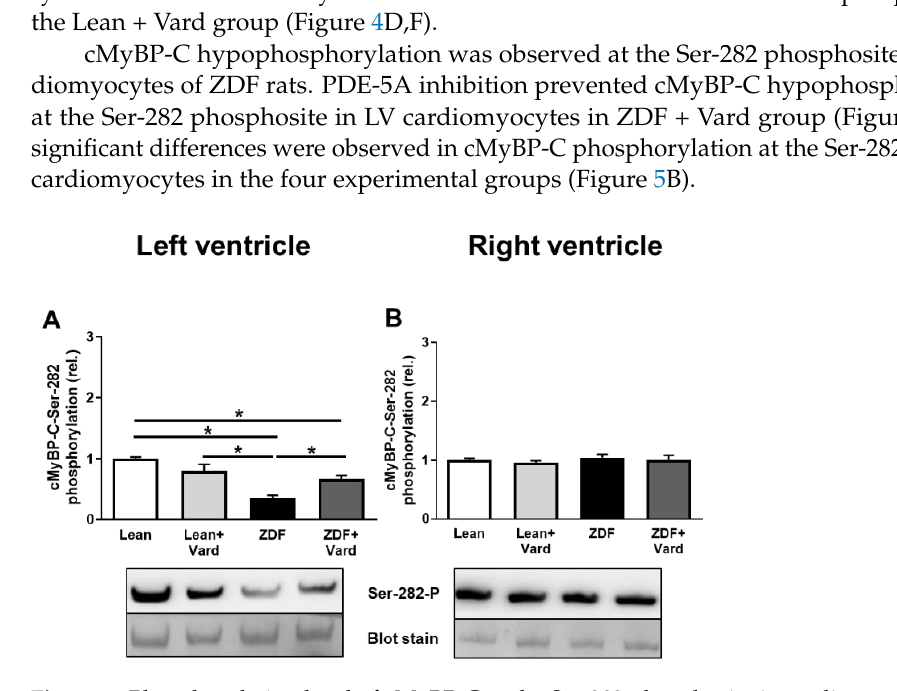
Figure 5. Phosphorylation level of cMyBP-C at the Ser-282 phosphosite in cardiomyocytes of left ventricles ( A ) and right ventricles ( B ) of the experimental groups. Phosphorylation levels of cMyBP-C were assayed by Pro-Q ® Diamond phosphoprotein staining. The upper bands illustrate the phosphorylation status of cMyBP-C and the lower bands indicate the total protein amounts for representative membranes. cMyBP-C phosphorylation levels at the Ser-282 phosphosite: LV Lean, 1.00 ± 0.03; LV Lean + Vard, 0.80 ± 0.11; LV ZDF, 0.35 ± 0.06; LV ZDF + Vard, 0.67 ± 0.06; RV Lean, 1.00 ± 0.03; RV Lean + Vard, 0.96 ± 0.03; RV ZDF, 1.05 ± 0.06; RV ZDF + Vard, 1.01 ± 0.08, all in relative units. n = 8 – 10 independent determinations from at least four different heart samples. Values are given as mean ± SEM, * p < 0.05 vs. control (Lean) group.